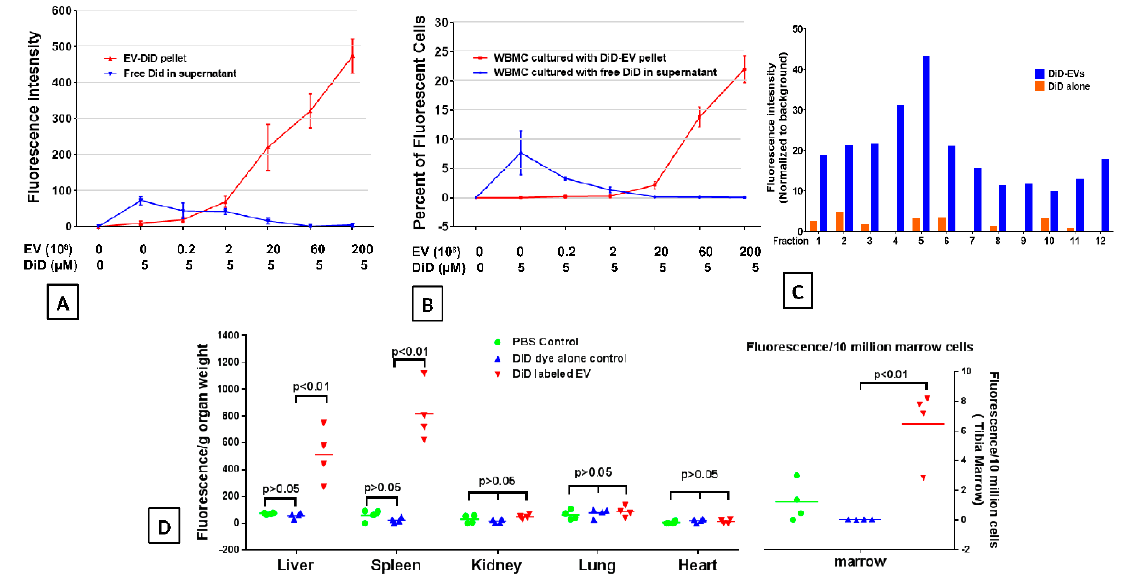
Figure 2. DiD dye labelling EVs. ( A ) Fluorescent intensity of free DiD in supernatants and DiD-EVs pellets after EV labeling and PBS washing were analyzed by FMT. ( B ) Whole bone marrow (WBM) cells were cultured with supernatants and DiD-EV pellets respectively. The percentage of fluorescent WBM cells labeled with free DiD in supernatants and DiD-EV pellets uptake rate by WBM cells were detected by flow cytometry. ( C ) The fluorescence of DiD-labeled EVs and DiD alone—parallel pellets’ gradient fractions. The DiD-labeled EVs and DiD alone: parallel pellets, after PBS washing, were fractionated by density gradient and the twelve fractions were collected and the fluorescent intensity each fraction was analyzed by FMT. ( D ) Fluorescence intensities of hearts, lungs, kidneys, livers, and spleens from mice injected with DiD-labeled EVs were analyzed by FMT. The intensity of fluorescence was expressed as the average of fluorescence intensity (count / energy) / weight of tissue or 10 million bone marrow cells ± SEM. The results were analyzed by one-way ANOVA with a multiple comparisons test. A P value ≤ 0.05 was considered statistically significant. DiD-labeled EVs versus PBS control or DiD dye control. n = 4 mice/group.